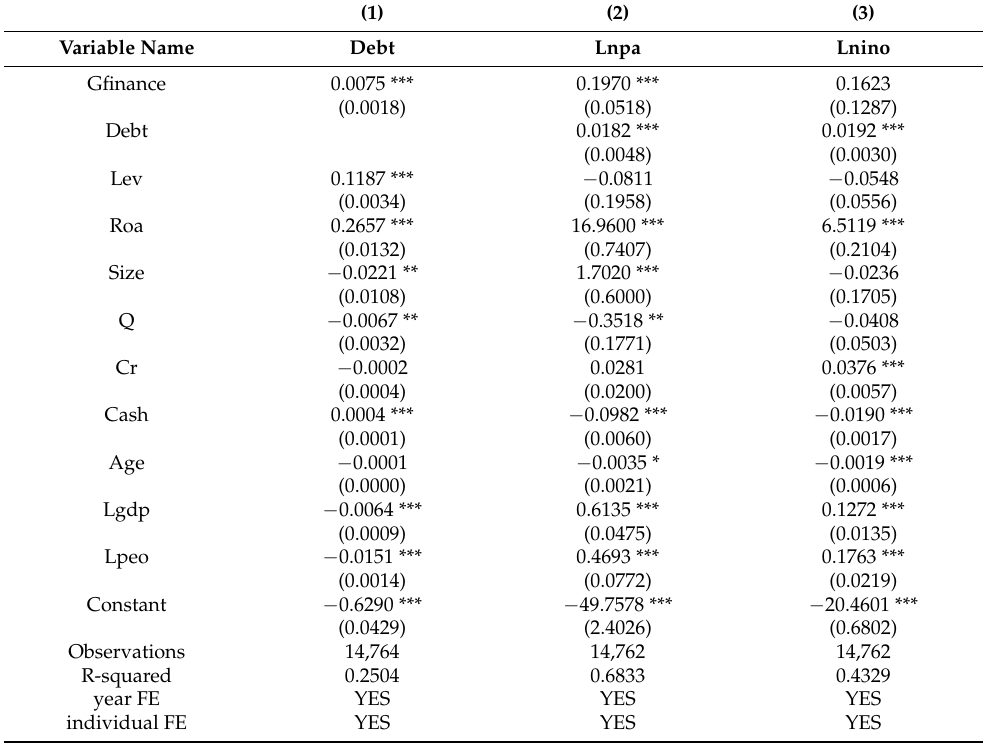
Table 7. Tests of the mediating effect of credit